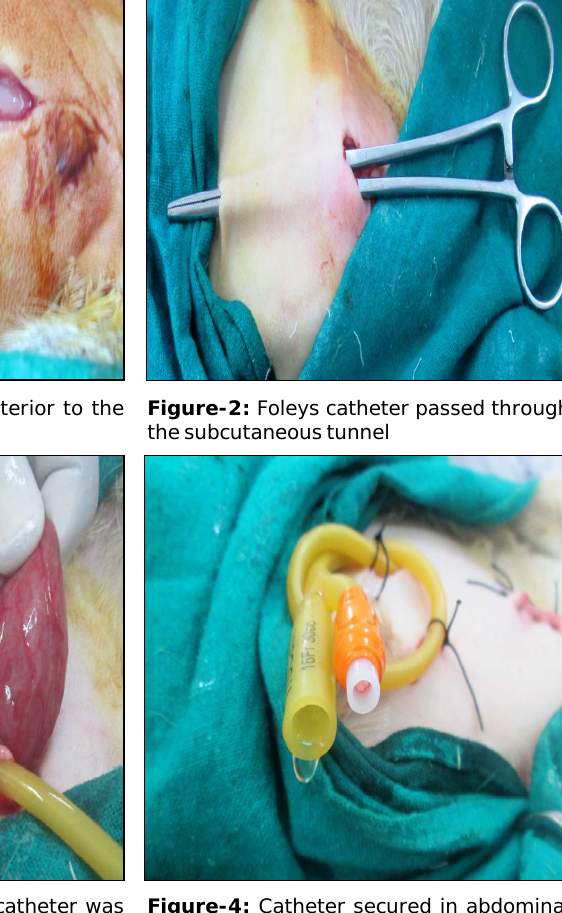
Figure-4: Catheter secured in abdominal skin with stay suture and free flow of urine through